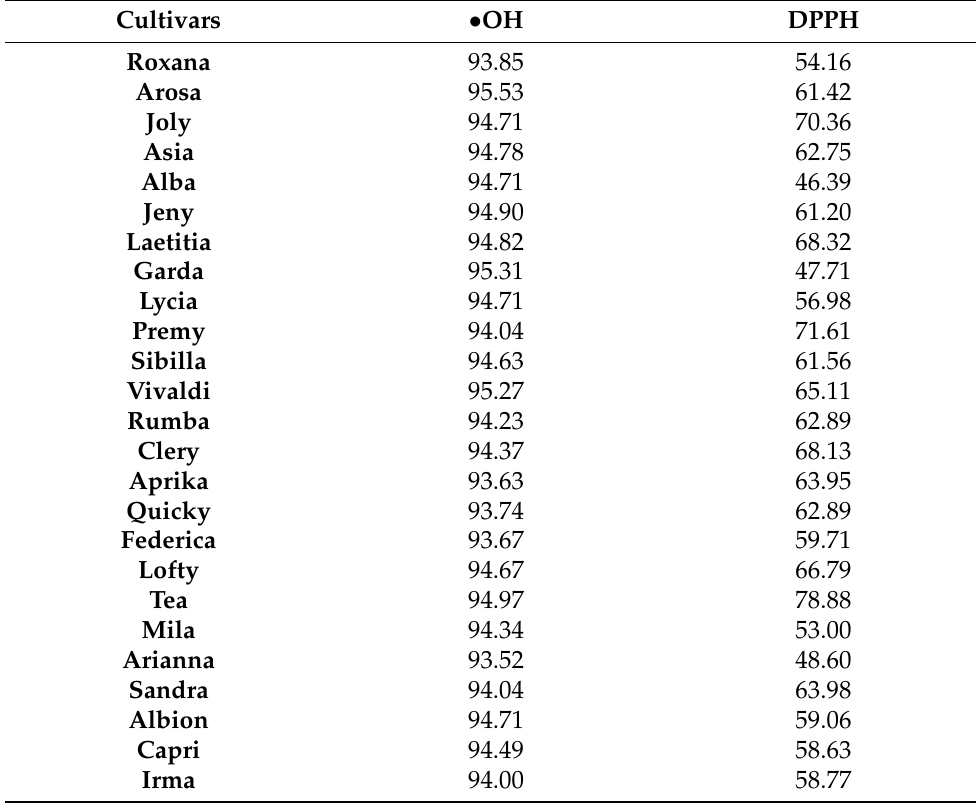
Table 2. • OH and DPPH radical scavenging activity (%) of strawberry fruit extracts estimated by electron paramagnetic resonance (EPR) spectroscopy in combination with the spin-trapping